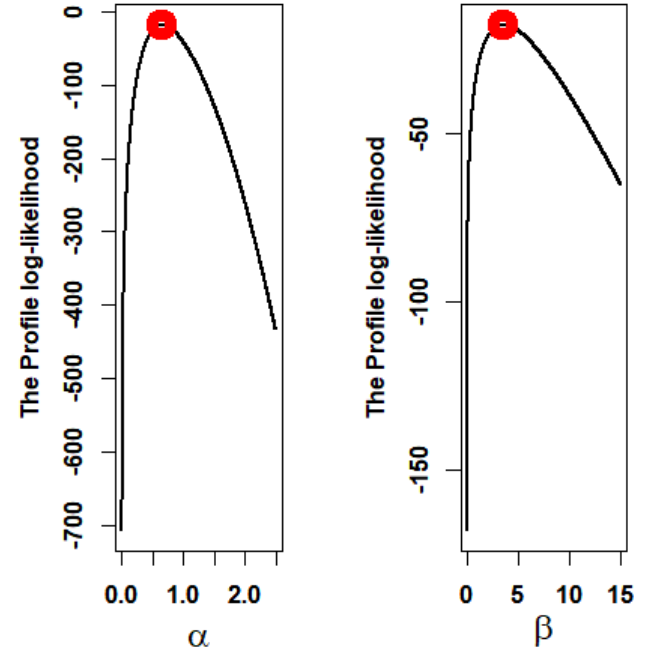
Figure 4. The profile log-likelihood plot for the second data set.